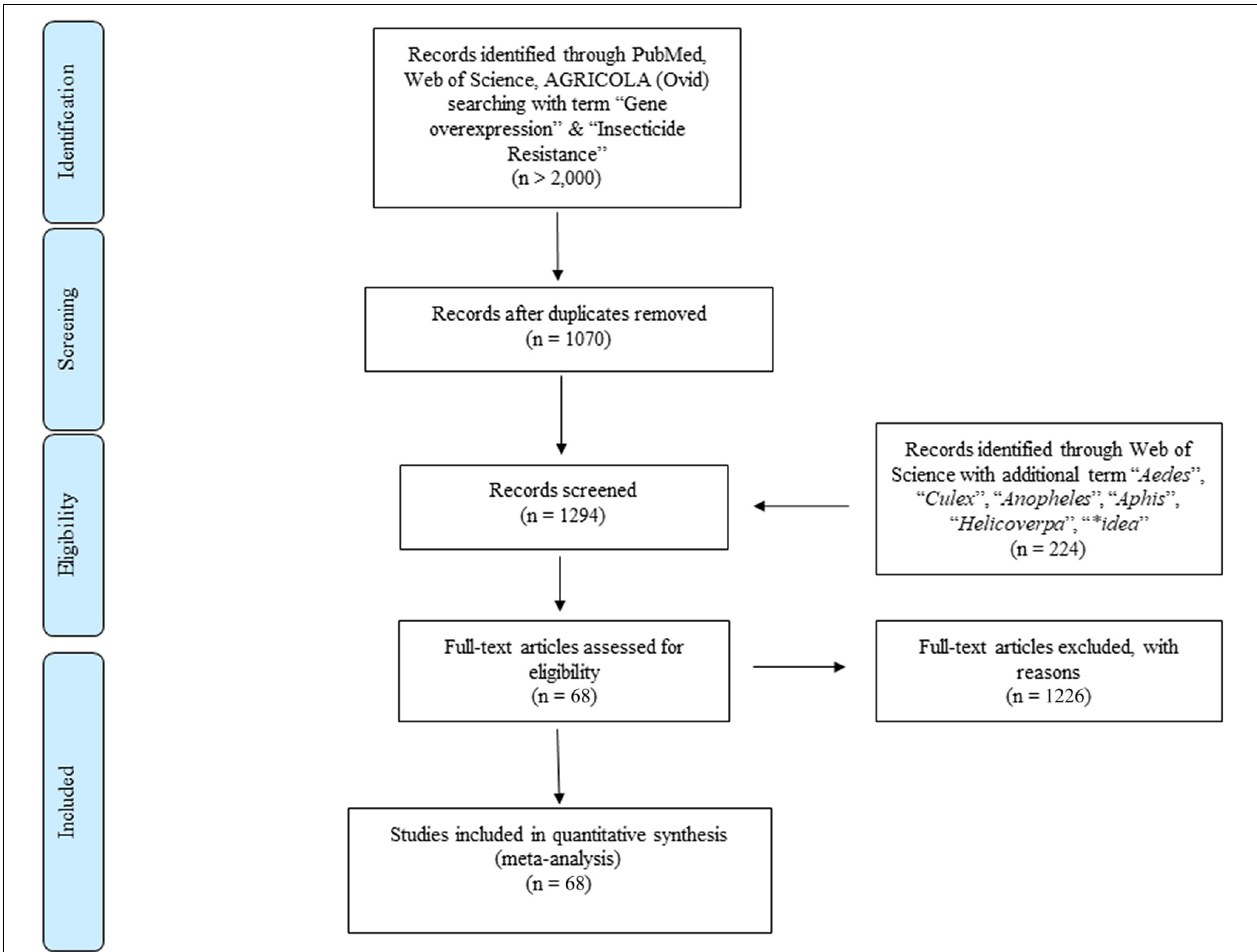
FIGURE 1 | Flow diagram based on